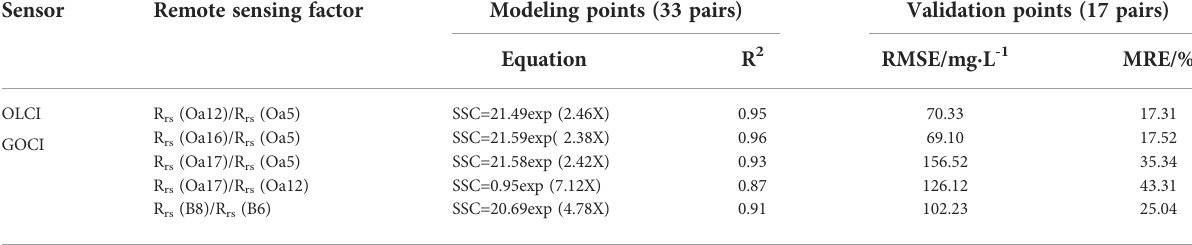
TABLE 3 Band-by-band RMSE and MRE statistics of atmospheric correction results based on OLCI and GOCI.